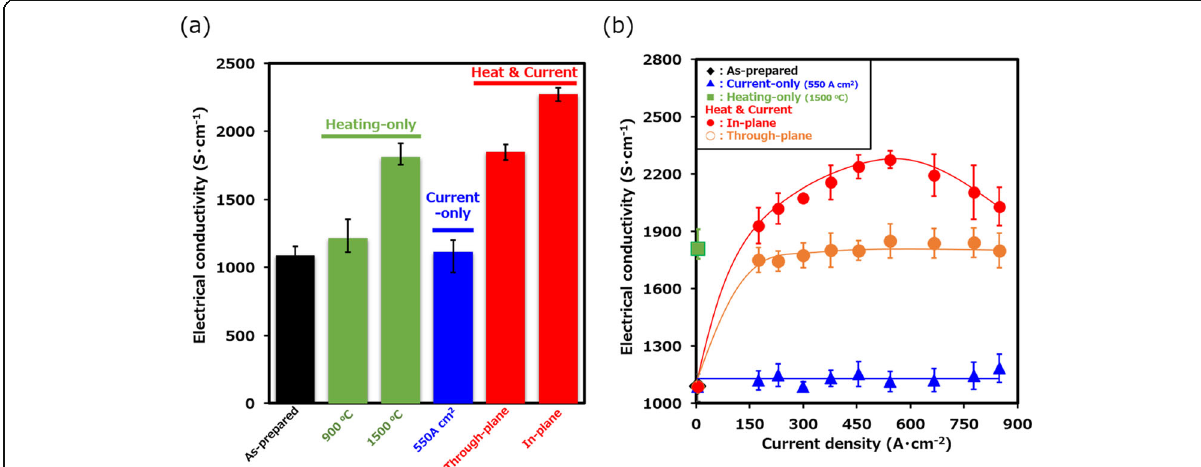
Fig. 2 a Electrical conductivity of the graphite sheets for the as-treated case and following different treatment conditions. b Dependence of the electrical conductivity dependence on the applied current density for different treatment conditions (Current-only, heat and in-plane current, and heat and through-plane current.) Heating-only and as-prepared are included as